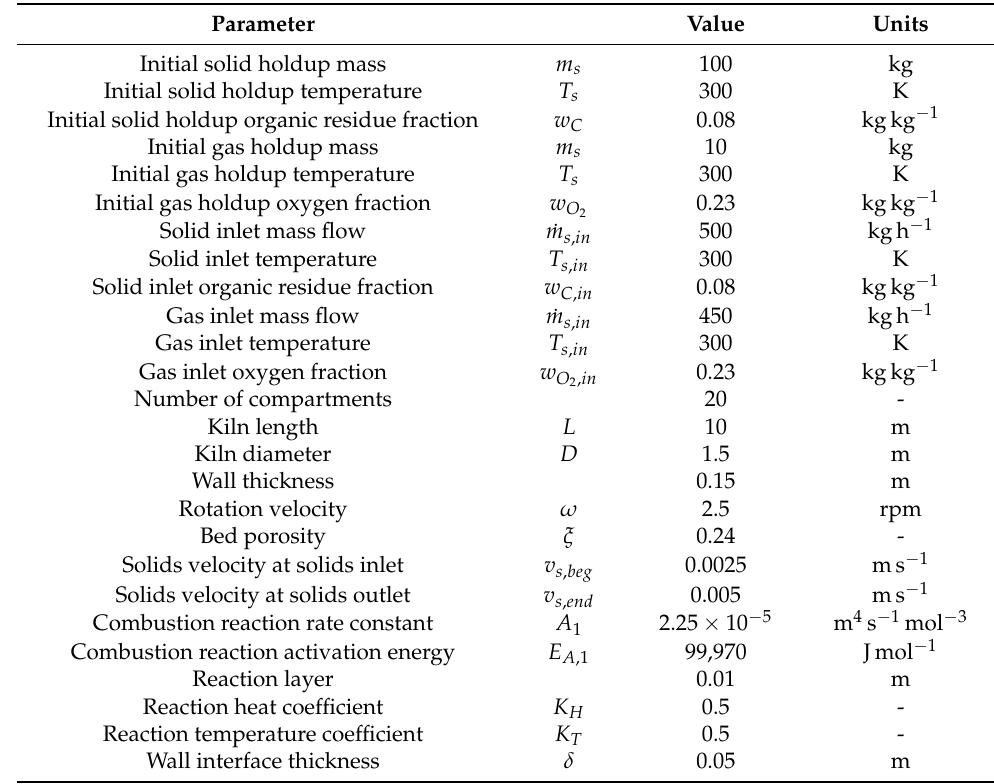
Table A3. Model parameters of the Calciner unit used in Section3.2.